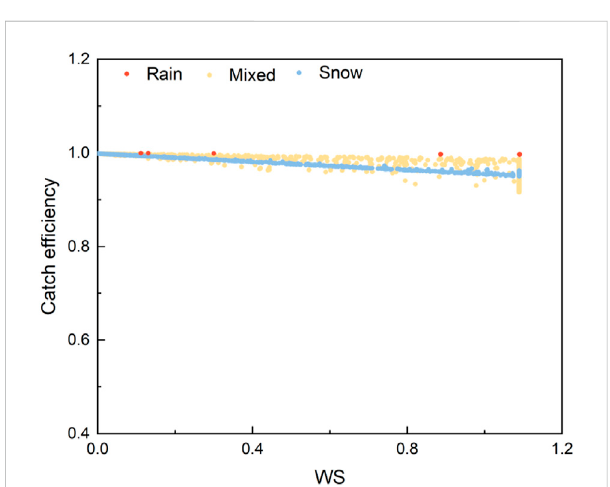
FIGURE 3 Distribution of the catch ef fi ciency for rain, snow, and mixed precipitation with the wind